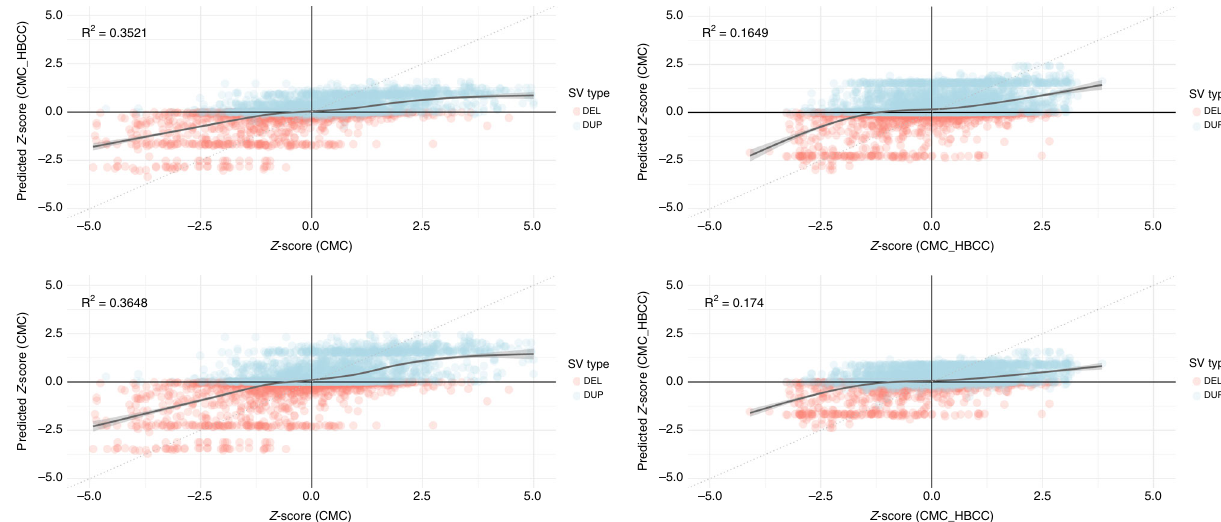
Fig. 5 Transcriptional consequences of rare CNVs can be signi fi cantly predicted. SV expression prediction performance and associated R 2 from building the same linear model using different training and test datasets. a CMC into CMC_HBCC, b CMC_HBCC into CMC, c CMC into CMC, and d CMC_HBCC into CMC_HBCC. The best fi t line with con fi dence interval was produced using generalized additive model smoothing.